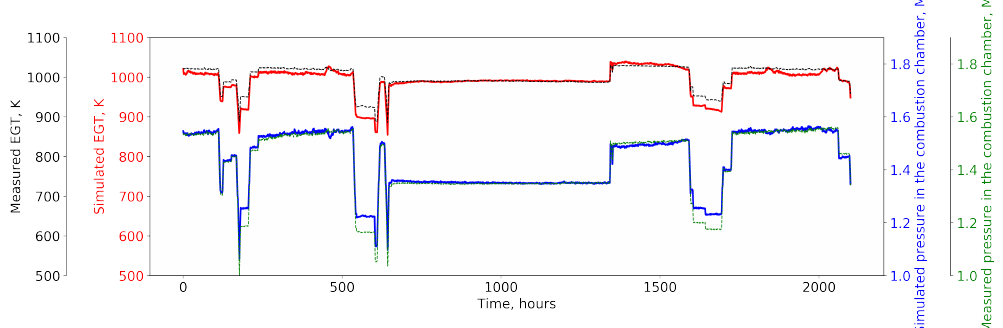
Figure 6. Simulated and measured combustion pressure and EGT